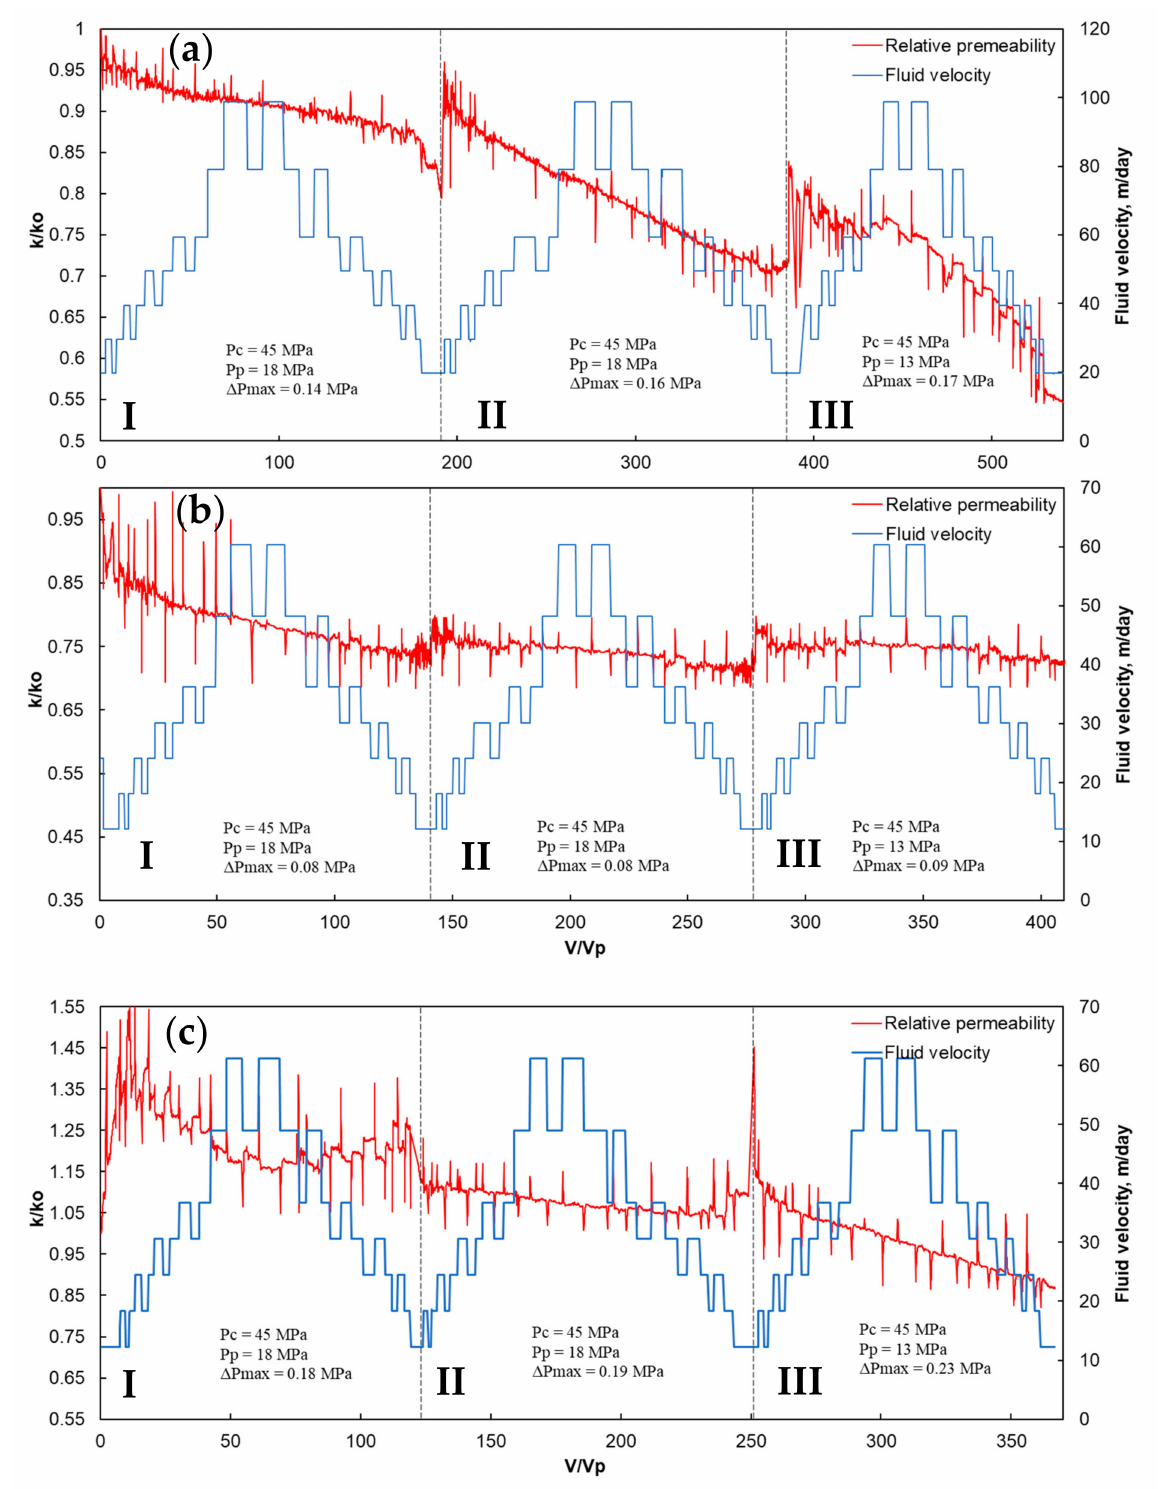
Figure 6. Relative permeability dynamics of samples IEKEV5600 ( a ), IEKEV5601 ( b ), IEKEV5602 ( c ) during 3 kerosene injection cycles. Roman numerals indicate the number of injection cycles. Dashed black lines show the boundaries between injection cycles—24-h pauses, during which the sample was kept at constant temperature, pore and confining pressures without injection. Samples IEKEV5600 and IEKEV5601 were flooded in the forward direction, sample IEKEV5602 was flooded in the reverse direction from the first deionized water